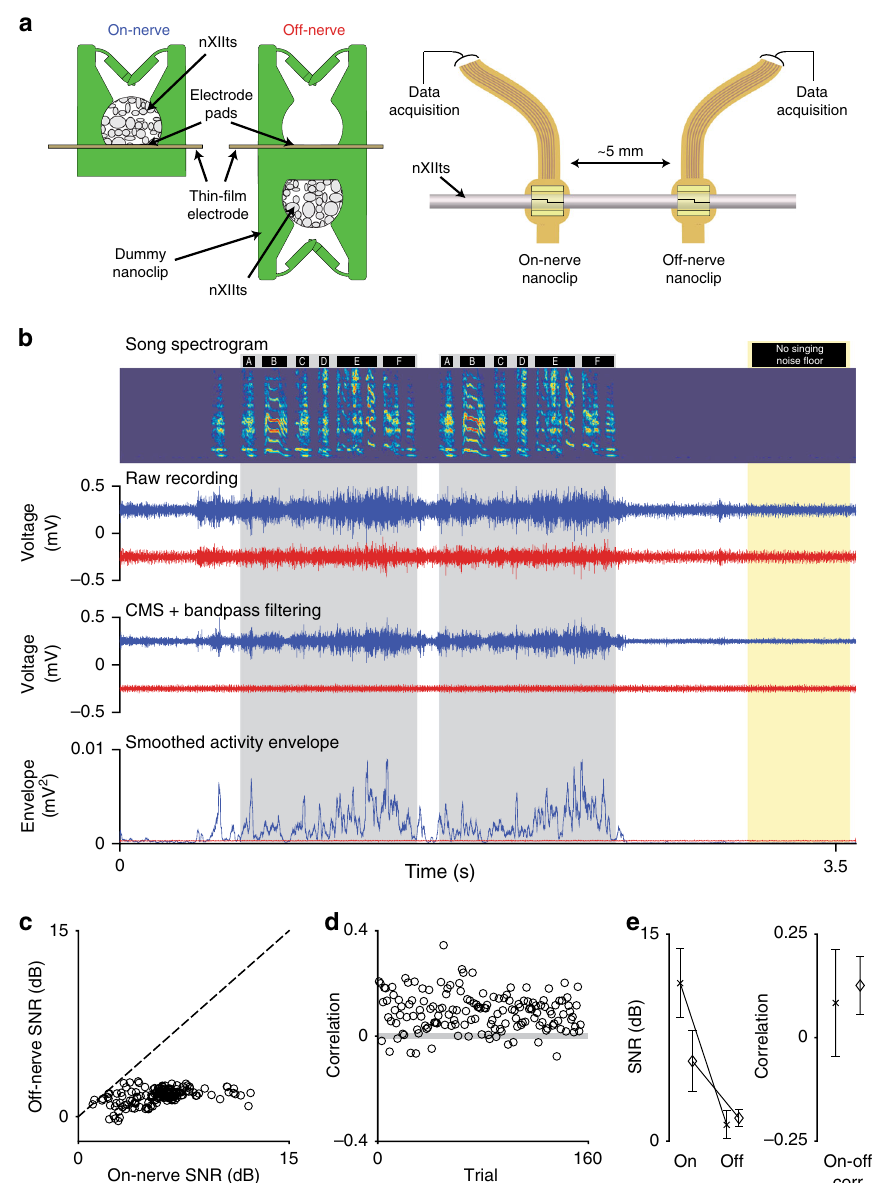
Fig. 5 Experiments addressing the neuronal origin of recorded signals. a Schema for simultaneous two-nanoclip chronic recordings. (Left) On-nerve recordings were made with the standard nanoclip design (used in all other experiments) in which the implanted nerve rests within the cavity and in contact with the electrode pads. Off-nerve recordings were made using a modi fi ed device with a second “ dummy ” nanoclip on the underside of the interface, keeping the electrode pads out of contact with the nerve and able to capture nonneuronal signals. (Right) nXIIt activity was recorded via an on-nerve nanoclip; control recordings were made via an off-nerve nanoclip interface placed ~5 mm caudally. b Representative example of simultaneous on-nerve and off-nerve chronic recordings. Top row: spectrogram of bird ’ s song containing two repeated song motifs. Black bars above the spectrogram indicate syllable boundaries; gray bands denote song motifs. Yellow band identi fi es song and artifact-free section of the recording from which the noise fl oor was estimated for SNR. Second row: unprocessed signals from on-nerve (blue) and off-nerve (red) interfaces. Third row: on-nerve (blue) and off-nerve (red) signals (from second row) after CMS and fi ltering. Bottom row: smoothed envelope for on-nerve (blue) and off-nerve (red) signals. c Trial-by-trial comparison of SNR for on-nerve and off-nerve signals for the bird is shown in ( b ). Each circle represents an individual trial; dashed line indicates unity. d Trial-by-trial Pearson correlations between the on-nerve and off-nerve envelops for the bird are shown in ( b ). Each circle represents an individual trial; the gray-shaded box indicates the 95% CI for zero-correlation by bootstrap. e Summary of neuronal and nonneuronal chronic recordings from the nXIIts in two birds. (Left) SNR of on- and off-nerve signals. (Right) Correlation of singing-related signal envelopes for on- and off-nerve signals. For each plot, symbols indicate the mean across motifs for each animal; error bars indicate Std ( n = 154 and 56 motifs, respectively). Source data are provided as a Source Data ( P = 3.5 × 10 − 5 ; Fig. 7d). For comparison, we performed the same birds; Fig. 7d). These experiments suggest that each current- within- and across-type acoustic similarity analysis on naturally steering pattern activated distinct subsets of nerve fi bers and produced vocalizations, fi nding that the fi ctive experiment well could do so reliably across multiple renditions. Furthermore, it replicated the reliability and speci fi city with which the vocal suggests that in this preparation the nanoclip is capable of apparatus is controlled during natural singing ( P = 0.0016, n = 6 producing nerve activity states that are on average at least as